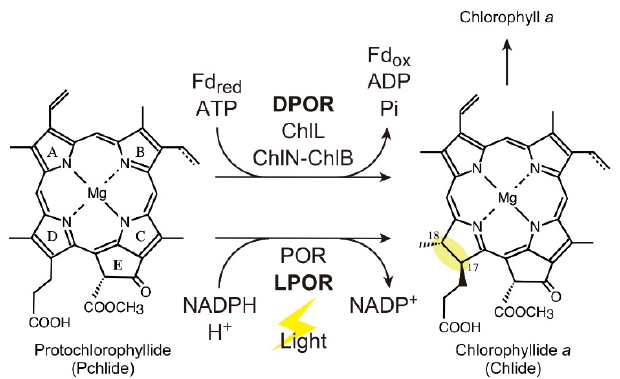
Figure 1. Pchlide reduction in the penultimate step of Chl a biosynthesis. In cyanobacteria, Pchlide is reduced by two evolutionarily unrelated enzymes, DPOR and LPOR. DPOR is a nitrogenase-like enzyme consisting of L-protein (ChlL dimer) and NB-protein (ChlN-ChlB heterotetramer). DPOR requires reduced ferredoxin (Fd) and ATP for catalysis. LPOR is a single polypeptide enzyme that uses NADPH as the reductant. Light is required for the catalysis of LPOR.